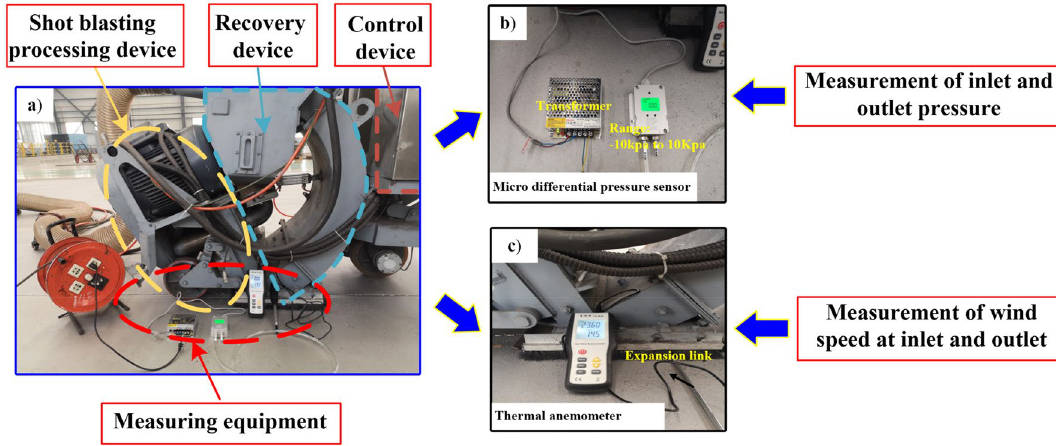
Figure 8. Model accuracy verification test equipment.